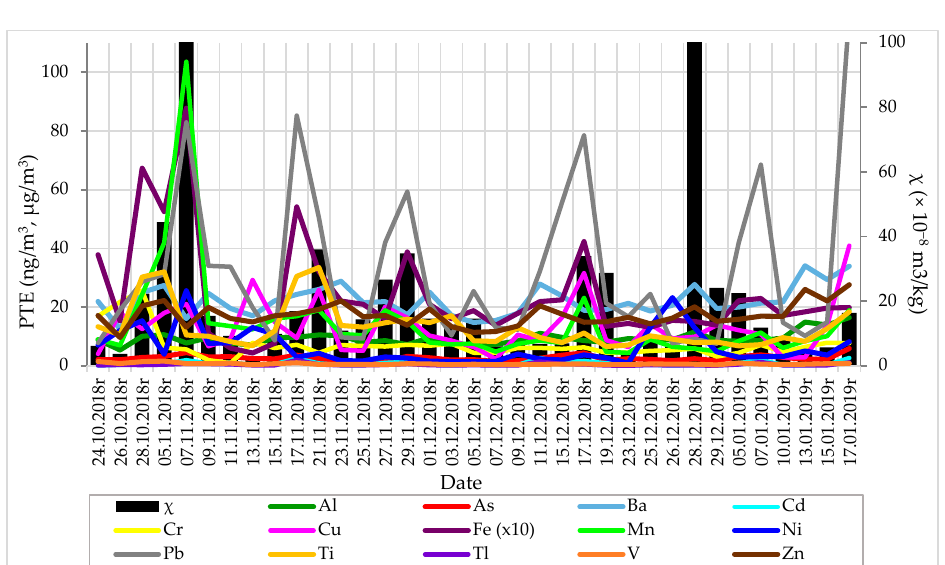
Figure 3. Mass-specific magnetic susceptibility ( χ ) and concentration of PTE ((As, Cd, Cr, Cu, Fe [×10], Mn, Ni, Pb, Ti, Tl and V in ng/m 3 ) and (Al, Ba and Zn in µg/m 3 )) in TSP daily filters.